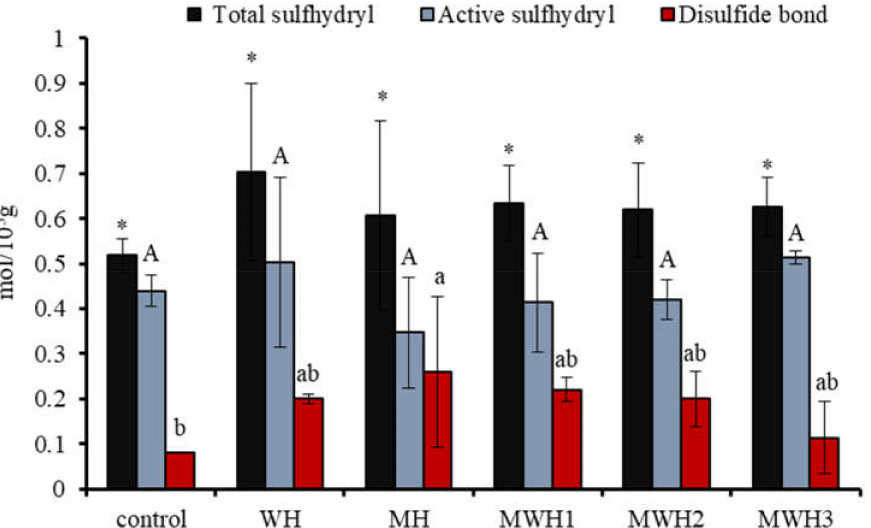
Figure 1. Changes in the content of myosin sulfhydryl groups and disulfide bonds under different heating conditions. Values with different upper-case letters, lower-case letters, and * are significantly different ( p <